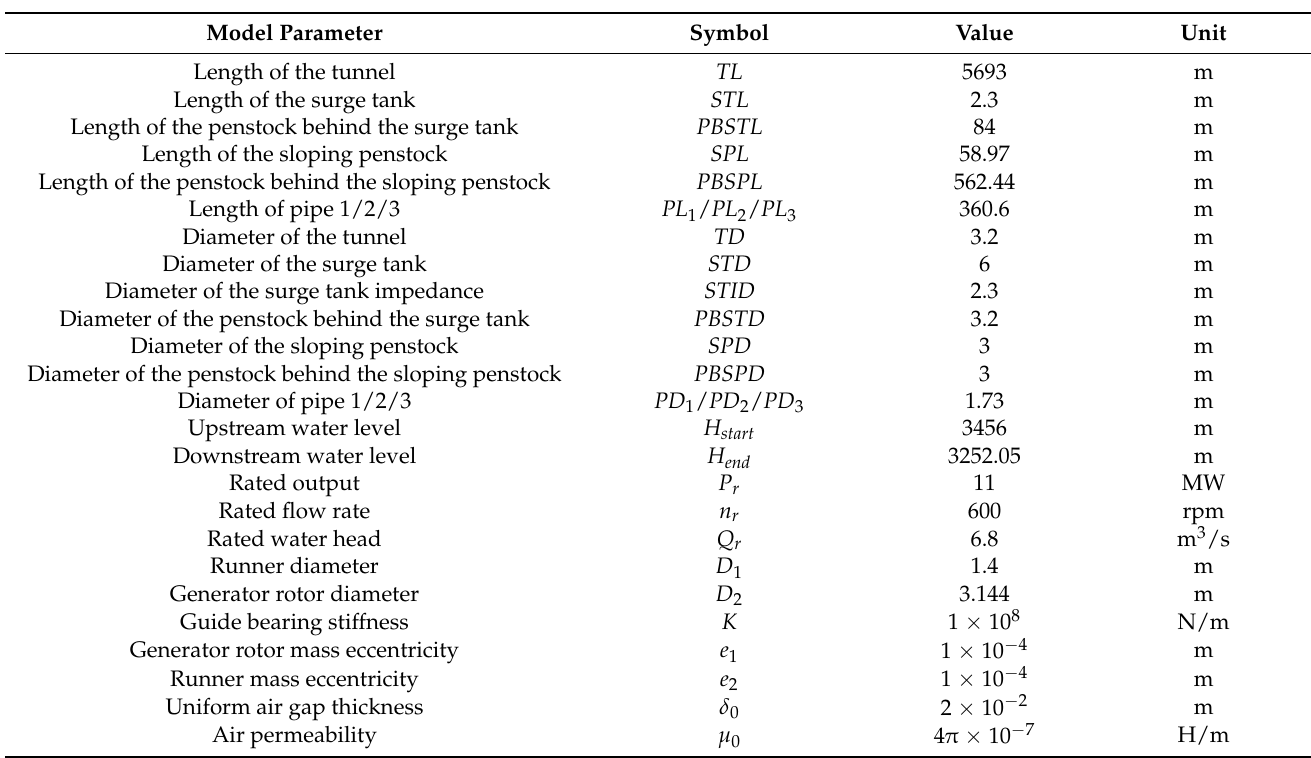
Table 1. The HGS parameters of Qinghai province in